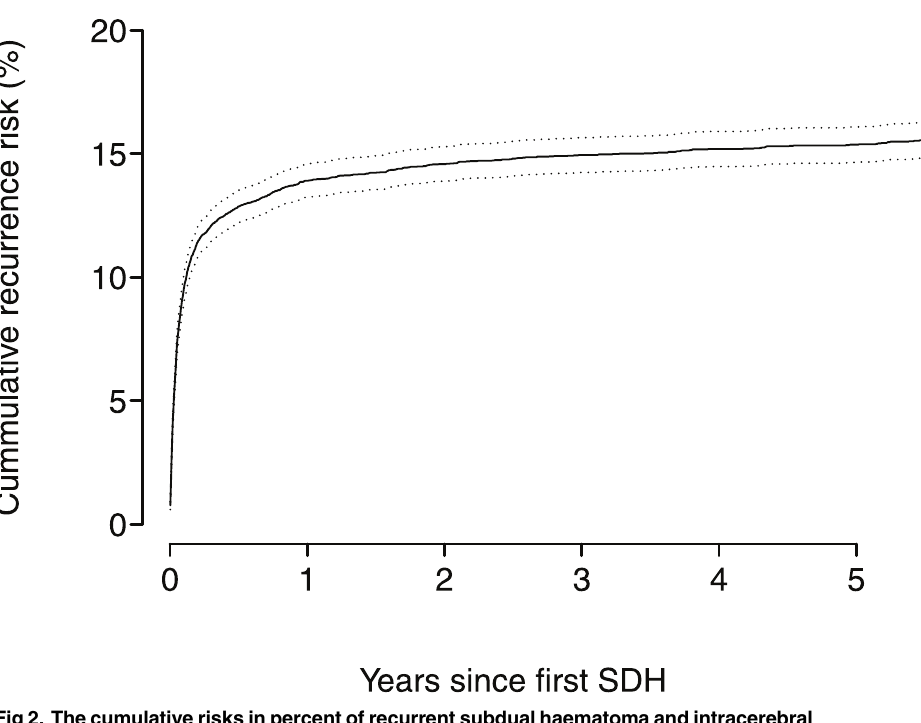
Fig 2. The cumulative risks in percent of recurrent subdual haematoma and intracerebral haemorrhage up to 5 years after the primary bleeding event.